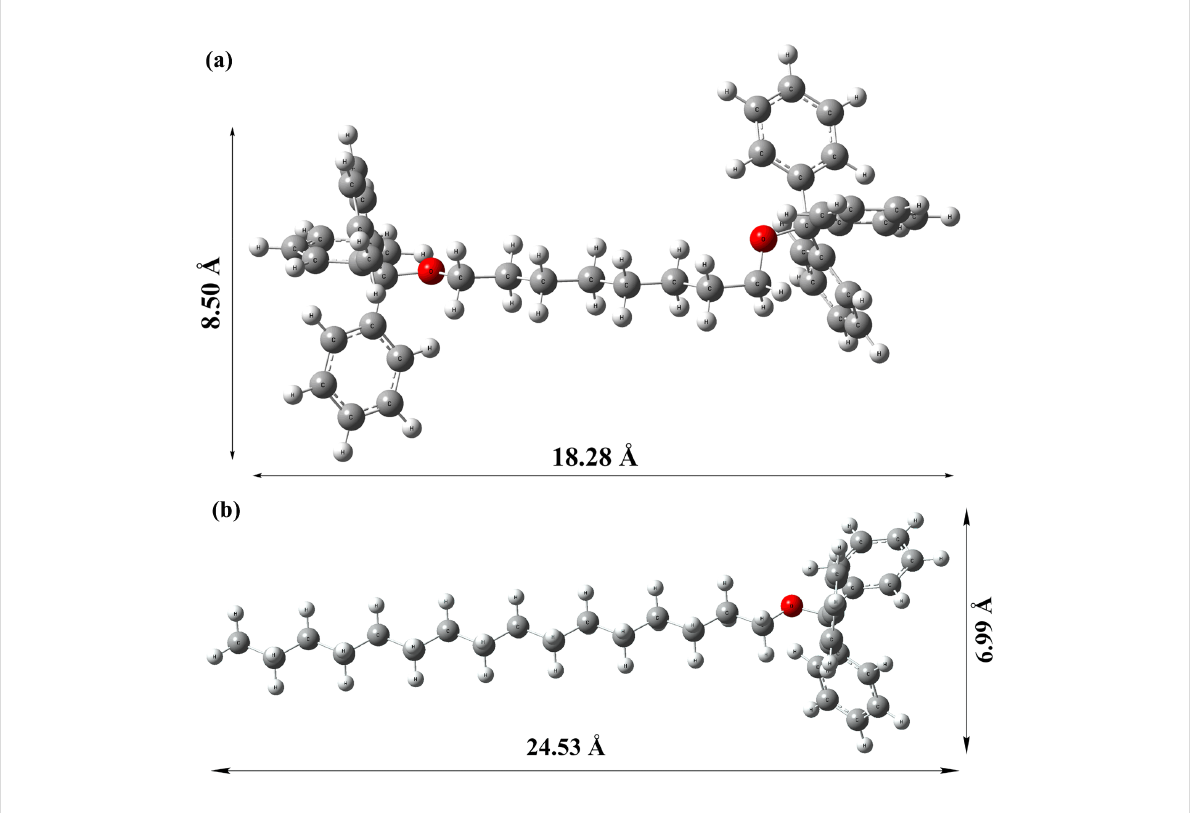
Figure 8: Energy minimized conformational structure of (a) TPM-G12 and (b) TPM-G5 obtained using B3LYP/6-31G (d, p) level of computations.